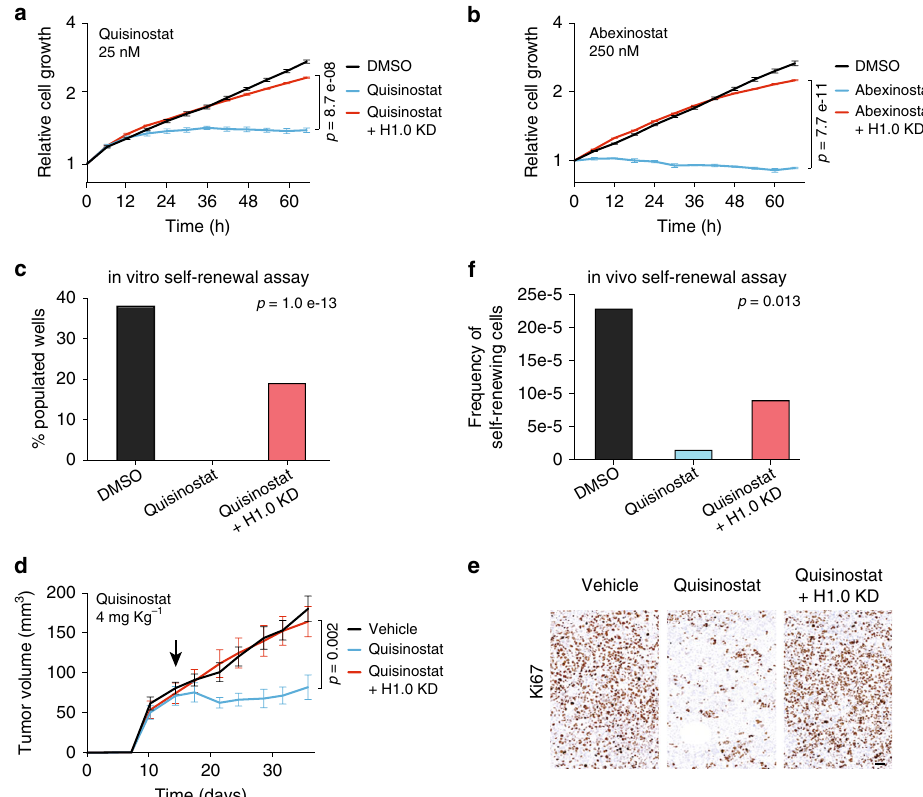
Fig. 4 Quisinostat inhibits cancer cell self-renewal by restoring high H1.0 levels. a , b IncuCyte proliferation assay on HCC1569 cells treated with the indicated HDACi. HCC1569 cells used in these experiments contain an inducible H1.0-targeting shRNA (shH1.0_1), which is either not expressed (Quisinostat/Abexinostat) or expressed to prevent H.10 upregulation (Quisinostat/Abexinostat + H1.0 KD). See also Supplementary Fig. 5e, h (independent H1.0-targeting shRNA and a non-targeting shRNA). Values represent mean ± s.e.m. from four biological replicates. Similar results were obtained in three independent experiments. p -value: one-tailed Student ’ s t -test calculated at the last time point. c Clonogenic assays measuring self- renewal ability of HCC1569 cells. The percentage of wells ( n = 96) populated by colonies is shown. Cells contain an inducible H1.0-targeting shRNA (shH1.0_1) which is not expressed (Quisinostat) or expressed to prevent H1.0 upregulation (Quisinostat + H1.0 KD). Cells were treated with 12.5 nM Quisinostat with (H1.0 KD) or without 0.5 µ g ml − 1 Doxycycline. With DMSO-treated H1.0 KD cells, the percentage of populated wells was 39.6%. The signi fi cance of the overall difference among the conditions is indicated (three-way contingency table analysis and two-tailed Fisher ’ s exact test). d Tumor maintenance assay. Growth kinetics of HCC1569-induced tumors treated with 4 mg kg − 1 Quisinostat or vehicle. Injected cells contain an inducible H1.0- targeting shRNA (shH1.0_1) which is either not expressed (Quisinostat) or expressed to prevent H1.0 upregulation (Quisinostat + H1.0 KD). Values represent mean ± s.e.m. from eight tumors. p -value: one-tailed Student ’ s t -test calculated at the last time point. Arrow: start of treatment. Similar results were obtained in an independent experiment. See also Supplementary Fig. 5k. e Immunodetection of proliferating (Ki67 + ) cells by immunohistochemistry in one of three tumors per condition. Scale bar: 50 µ m. f Limiting-dilution transplantation assay into NSG mice using cells from HCC1569-induced tumors treated with the indicated substances. The signi fi cance of the overall difference among the conditions is indicated ( χ 2 test). n = 6 tumors. Outgrowths/ injections for H1.0 KD: 4/6, 0/6, 0/6 and 0/6 for 10,000, 1000, 100, 10 injected cells, respectively. For the other conditions, see Fig. 2g. Data for all graphs in Source Data fi re-expression (Fig. 5a, Supplementary Fig. 6a, d). At each time point, we searched for genes affected by Quisinostat (FDR ≤ 0.01) relatively to the DMSO-treated control cells, and rescued in their expression by H1.0 knockdown (FDR ≤ 0.01). Quisinostat treat- ment induced detectable changes in gene expression by 30 min and a progressive increase in the number of differentially expressed genes (DEGs) over time, reaching ~10,000 by 10 h (Fig. 5b and Supplementary Fig. 6b). Most changes were mod- erate in magnitude (fold-change <2), indicating that Quisinostat treatment induces subtle but widespread transcriptional changes across the genome (Fig. 5b). Only 10% of all Quisinostat- responsive genes were rescued by H1.0 knockdown, indicating a role for these genes in self-renewal inhibition (Fig. 5c). Most H1.0-dependent genes were observed among early responders (30 min and 1 h), suggesting that the late transcriptional response is largely unrelated to the effect on cell self-renewal (Fig. 5c).